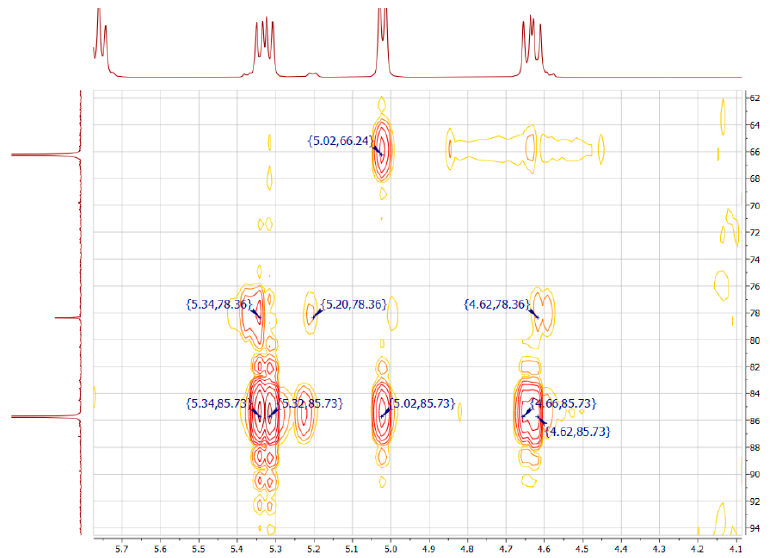
Figure 4. The range 90–60 ppm—5.7–4.1 ppm of 13 C— 1 H HMBC spectrum for 4,5-dihydroxy-1,3- bis(hydroxymethyl)imidazolidine-2-thione 6.